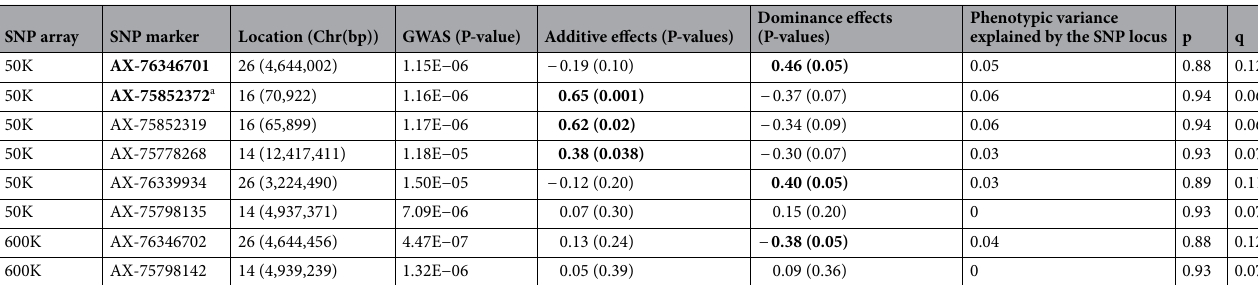
Table 1. List of SNPs significantly associated with log-transformed caecal Campylobacter levels in commercial chickens. SNP markers highlighted in bold were significant at the genome-wide level after Bonferroni correction. a More than 100 SNP markers on chromosome 16 were significant at the suggestive significant genome-wide level. p and q denote the allelic